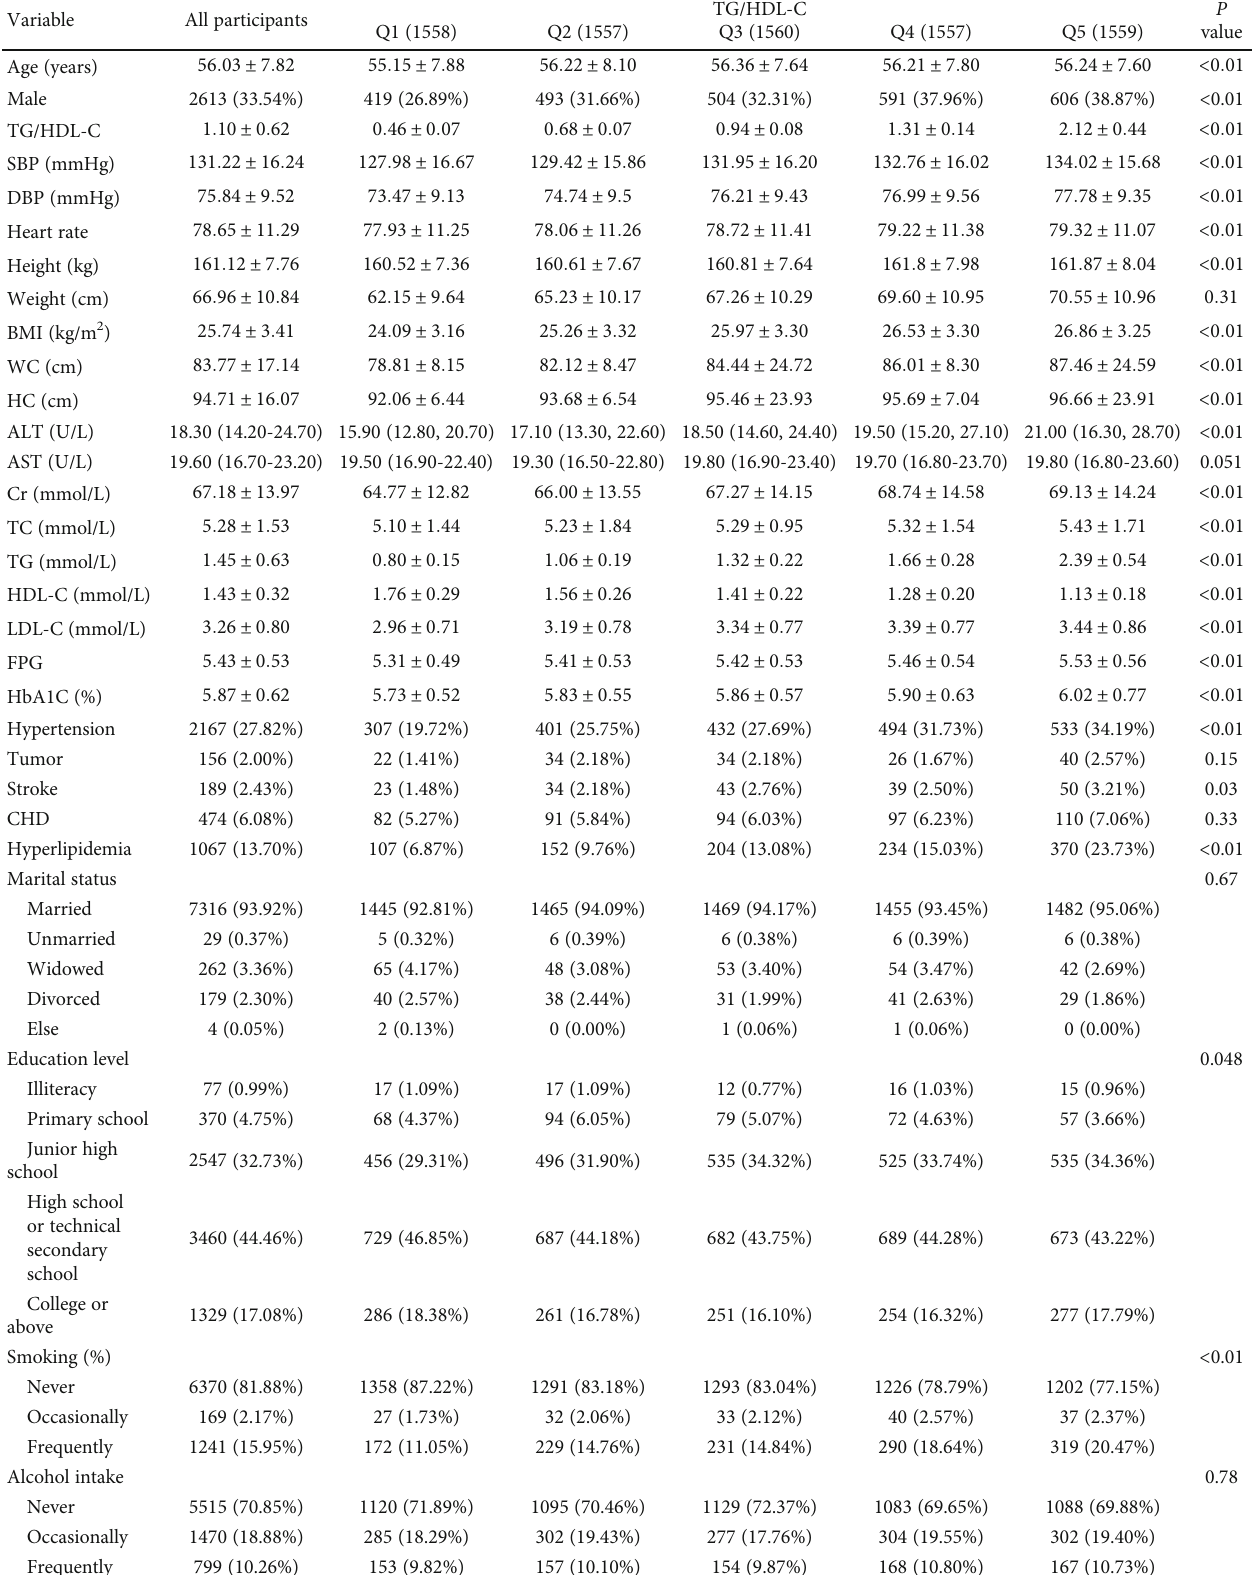
Table 1: Baseline characteristics of the participants in the REACTION study according to serum TG/HDL-C.